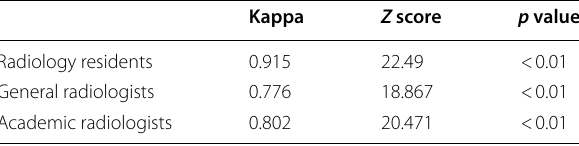
Table 4 Consistency evaluation between radiologists in the same category Kappa Z score p value Radiology